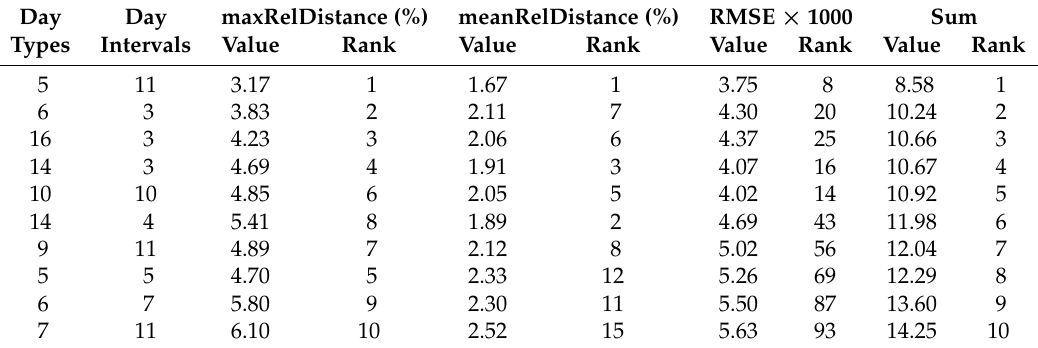
Table 7. Top model configurations for Portland: ranking by sum of three criteria.